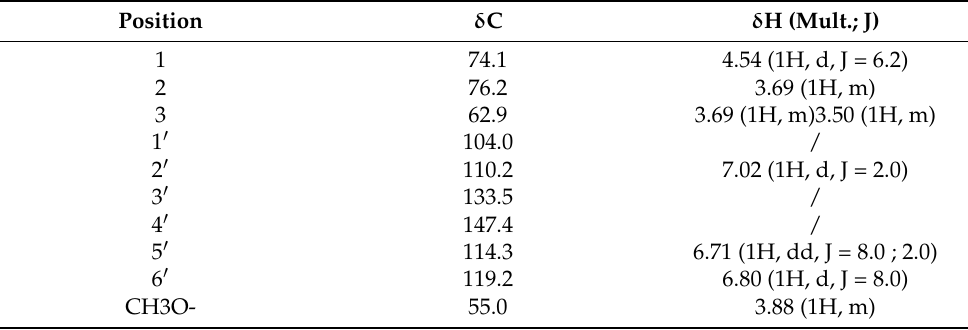
Table 1. 1H (500 MHz) and 13 C NMR (125 MHz) data for compound ( 1 ) in